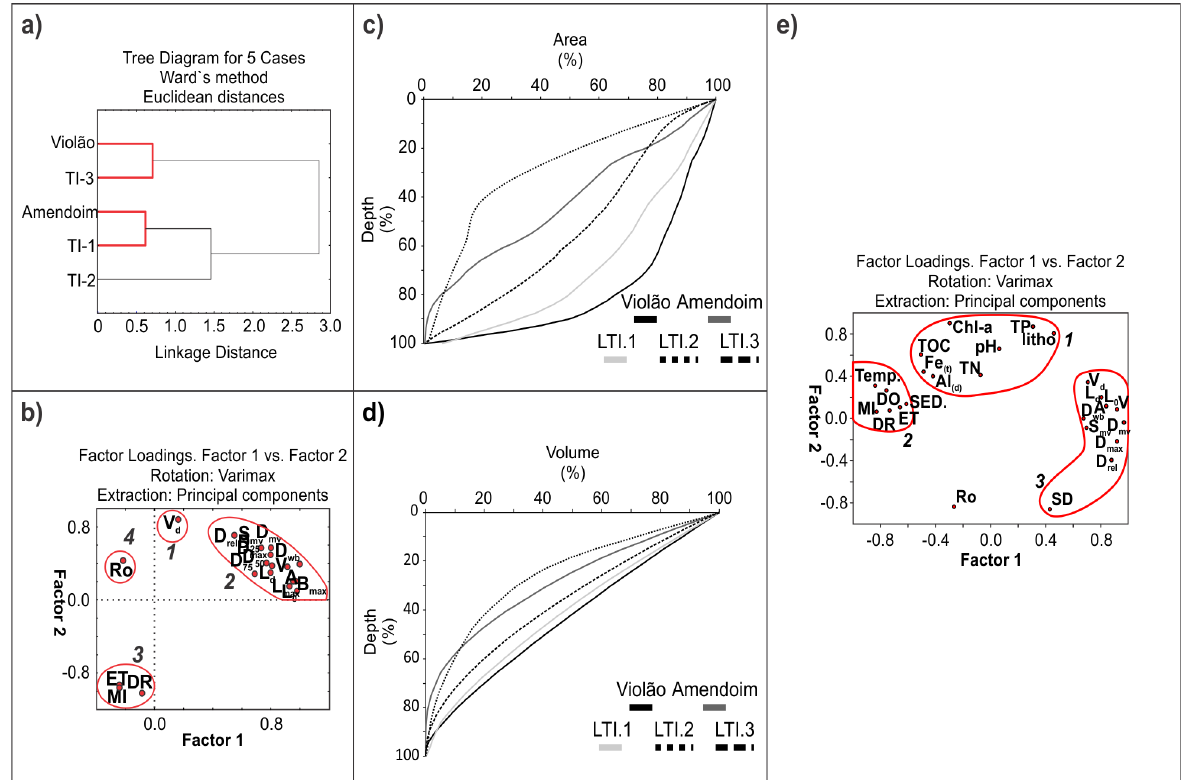
Figure 4 - Statistical analysis of morphometric parameters of the studied lakes according to a) similarities between lakes by cluster analysis, and b) relationship between parameters by factor analysis; B : maximum width; D : maximum depth; D : max max mv mean depth; D : median depth; D : quartile depths; L : shoreline length; A: area; V: volume; D : relative depth; L : 50 25-75 0 rel d